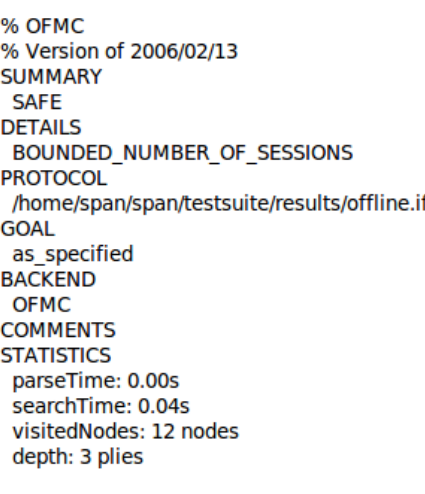
Figure 16. The OFMC back-end’s results.